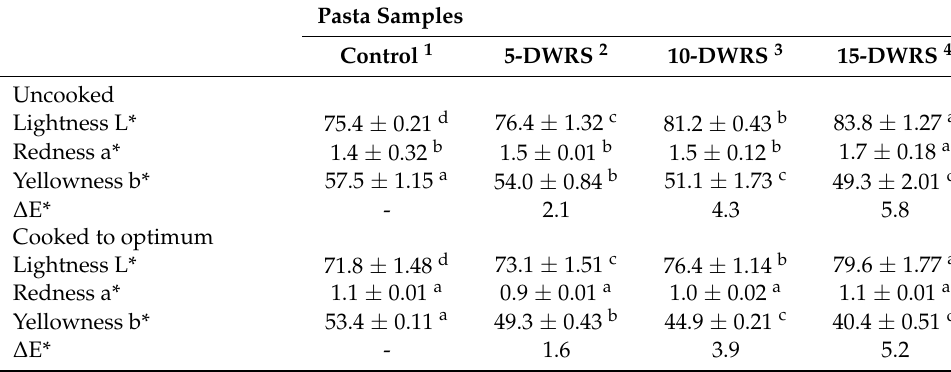
Table 2. Colour evaluation of semolina spaghetti containing resistant starch (RS) from debranched waxy rice starch (DWRS). Pasta Samples Control 1 5-DWRS 2 10-DWRS 3 15-DWRS 4 75.4 ± 0.21